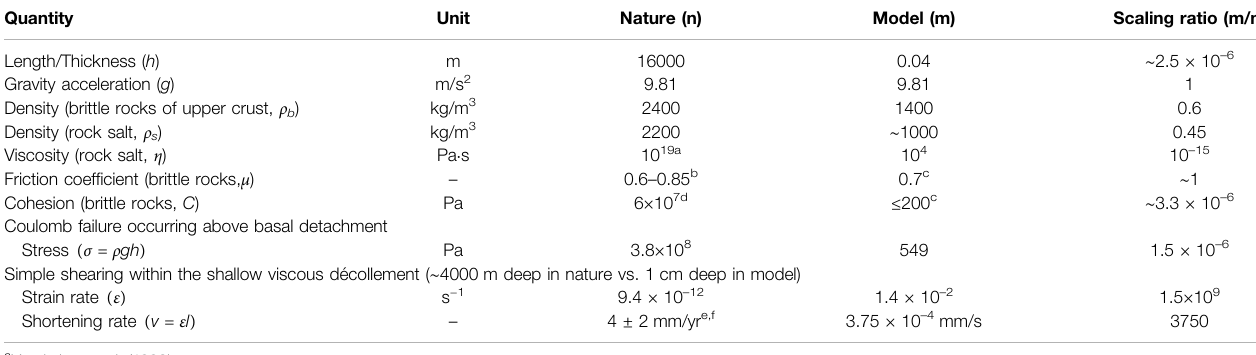
TABLE 1 | Material properties and scaling parameters between model and